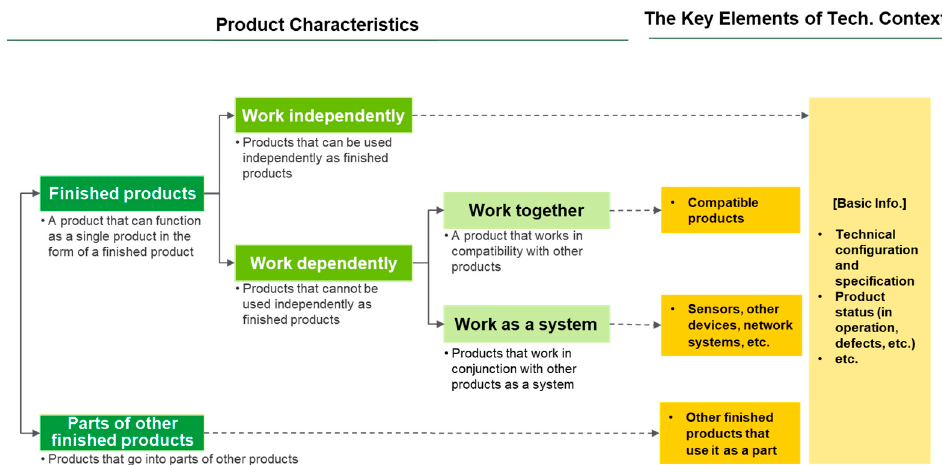
Figure 2. The Framework for the Context Analysis of a Product (Technological Context).